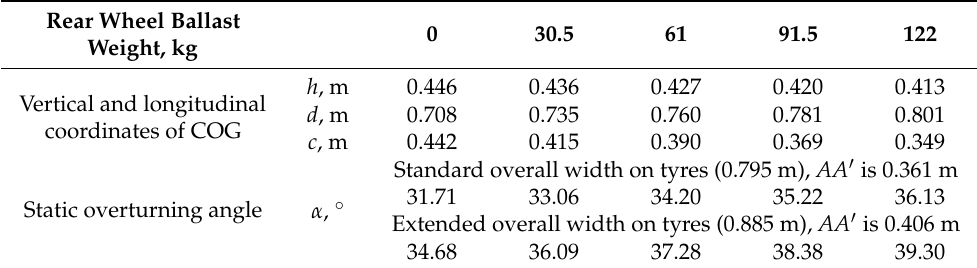
Table 2. Data calculated according to standard [12].